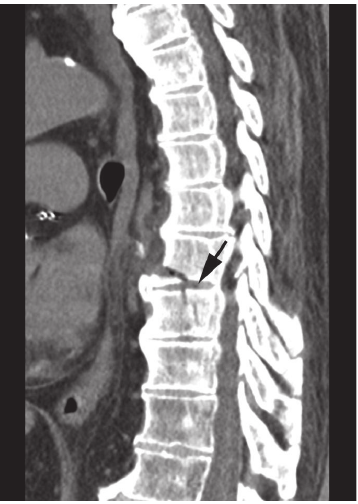
Figure 2: Sagittal CT scan of the thoracic spine showing an oblique fracture traversing the T8 inferior endplate, T8-T9 interspace, and posterior aspect of the T9 vertebral body ( arrow ).